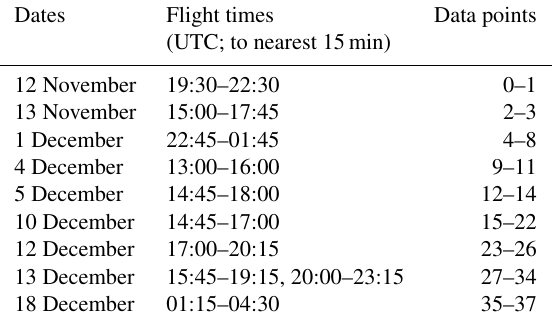
Table 4. List of selected Citation II flight missions after applying filter criteria with resulting collocated data